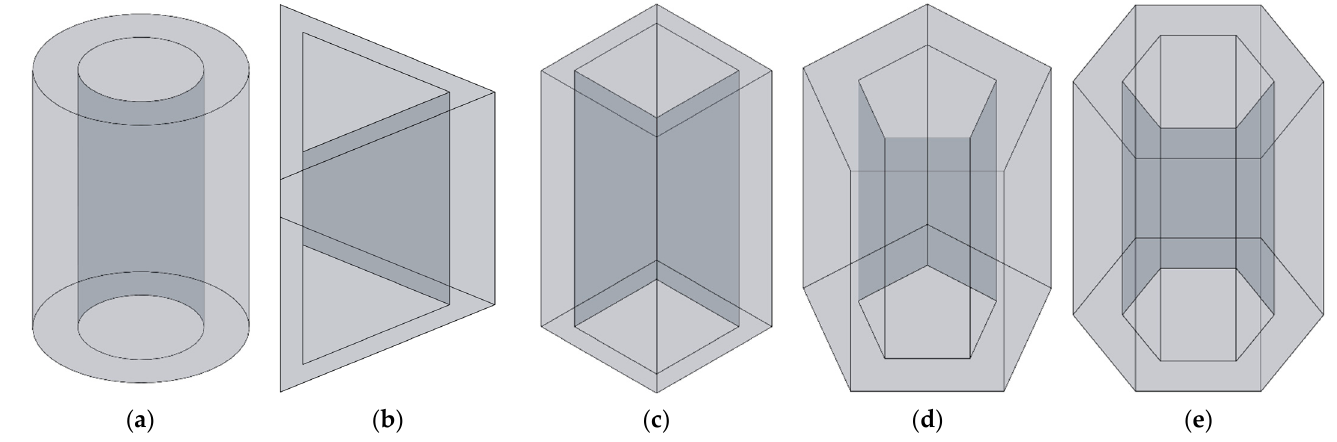
Figure 3. The three-dimensional structures of apertures for various cross-sectional shapes. ( a ) Round; ( b ) regular triangle; ( c ) square; ( d ) regular pentagon; and ( e ) regular hexagon.